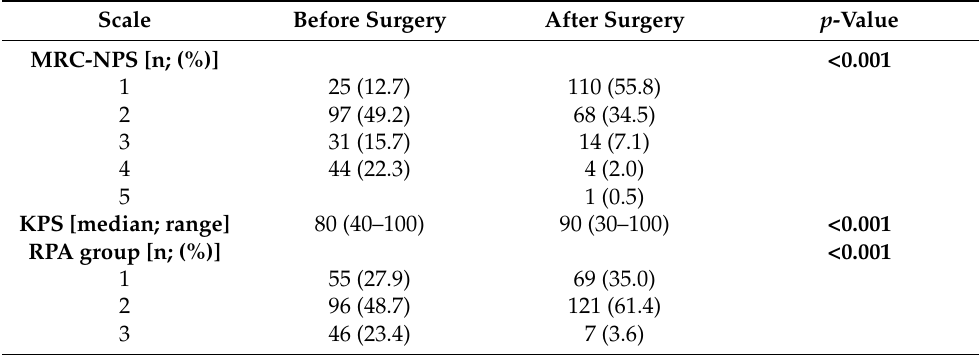
Table 2. Clinical scores and prognostic group allocation. Statistic changes in group allocation, calculated by Wilcoxon rank-sum